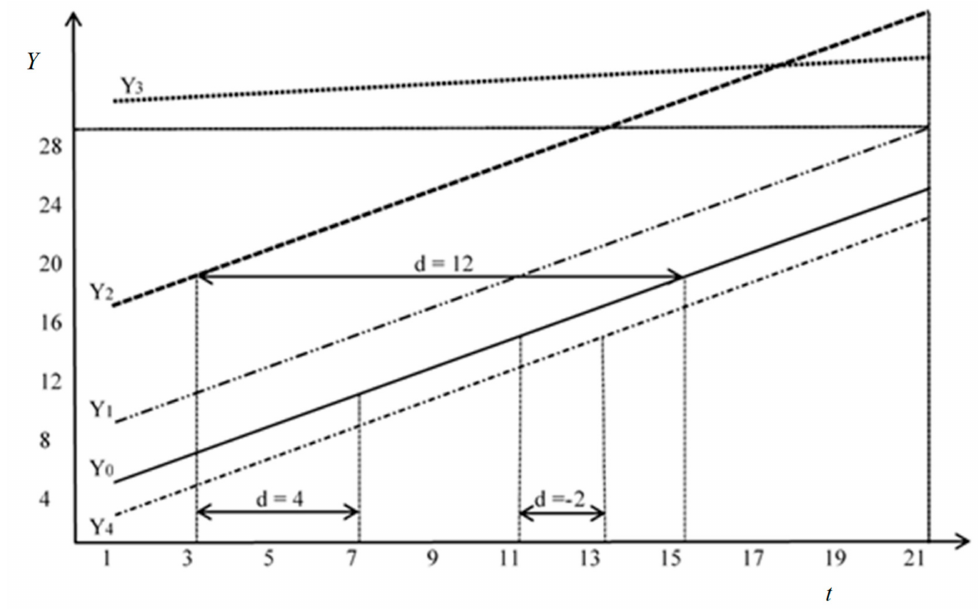
Figure 1. Time delays between the reference and the forecast